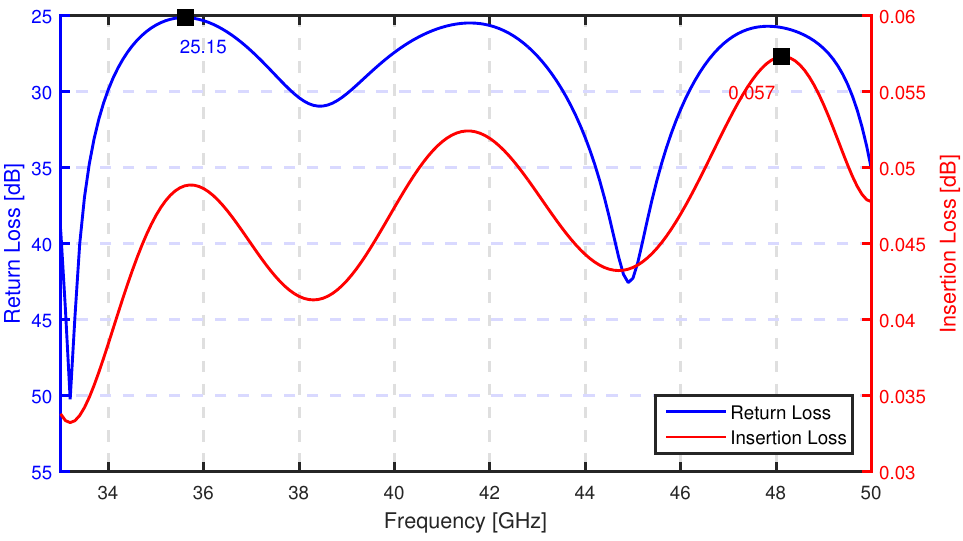
Figure 7. Return loss and insertion loss evaluated in the section between the transverse section of the coaxial cable upstream the air gap and the transverse section of the hollow waveguide. This section is far enough from the Chebyshev transformer to avoid issues due to higher modes in the ridges’ edges.